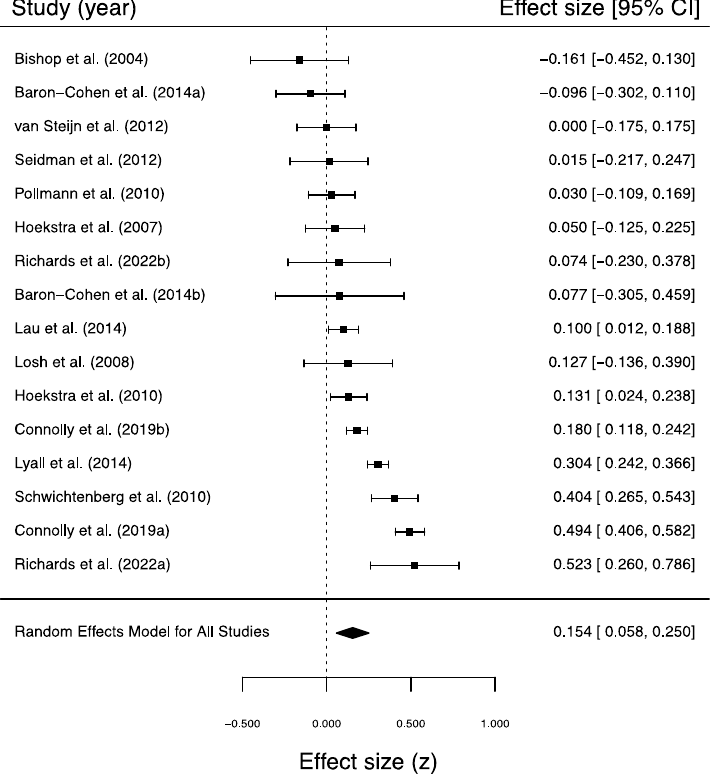
Figure 3. Forest plot for within-couple correlations for autistic traits. Note Baron-Cohen et al. (2014a) = parents of autistic children; Baron-Cohen et al. (2014b) = parents without autistic children; Connolly et al.